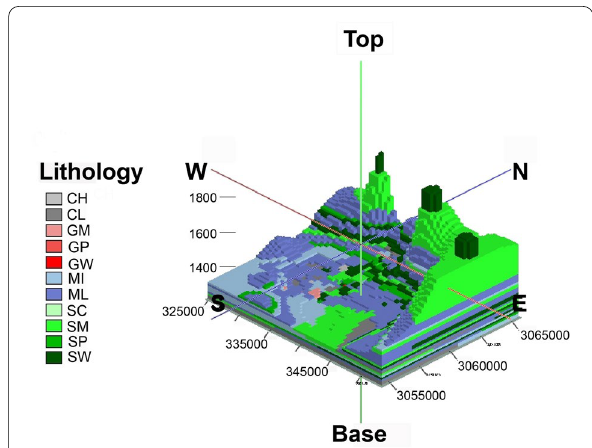
Fig. 3. 15 times vertically exaggerated 3D lithological model of the Kathmandu Valley created in Rockworks 2016 (The lithology descriptions are CH: high plastic clay, CL: low plastic clay, GM: silty gravel, GP: poorly graded gravel, GW: well-graded gravel, MI: